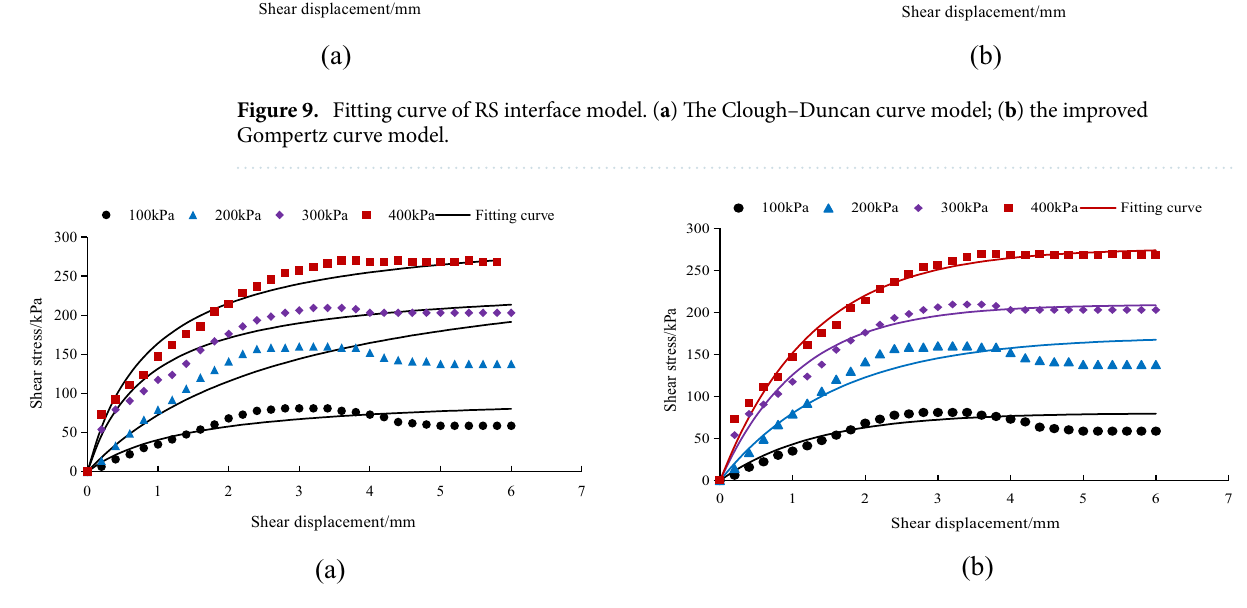
Figure 10. Fitting curve of NRS interface model. ( a ) The Clough–Duncan curve model; ( b ) the improved Gompertz curve model.